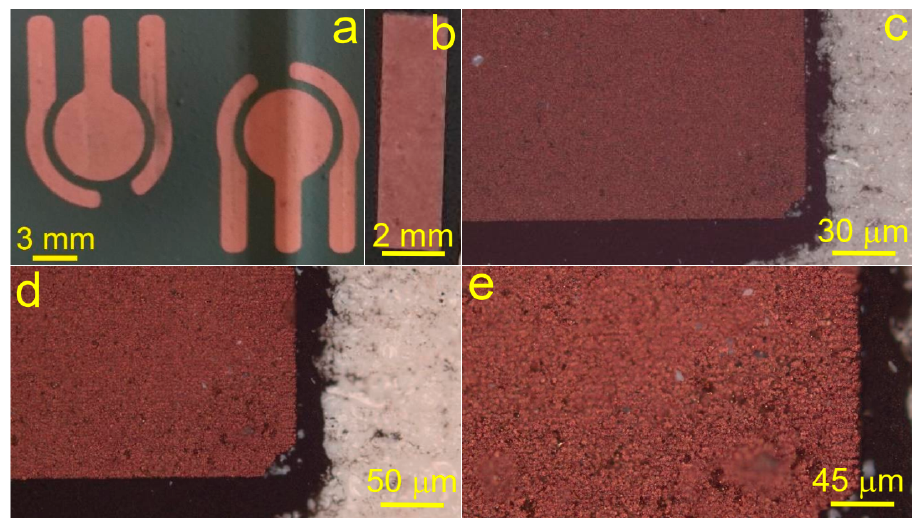
Figure 5. Photographs of copper micropatterns of different geometry fabricated on the surface of glass-ceramics using SLS. ( a ) Three-electrode geometry suitable for design of a sensor platform based on copper; ( b – e ) Pictures of copper rectangular microstructures of different scale. Black background corresponds to the area unexposed to the laser irradiation.